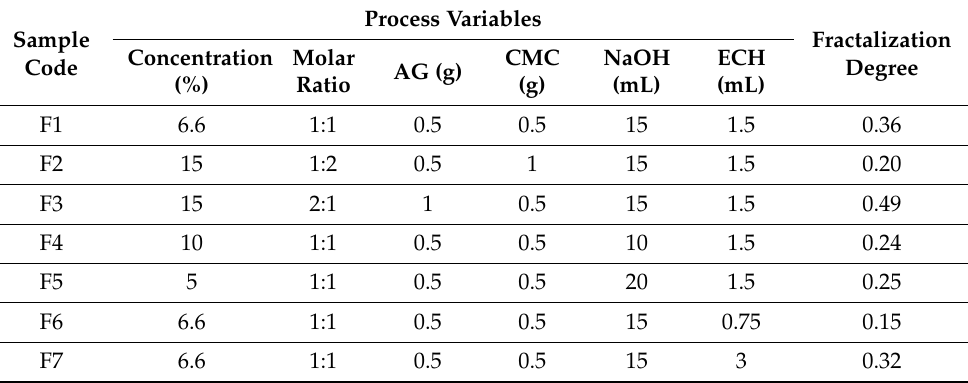
Table 5. Fractalization degree vs. reaction